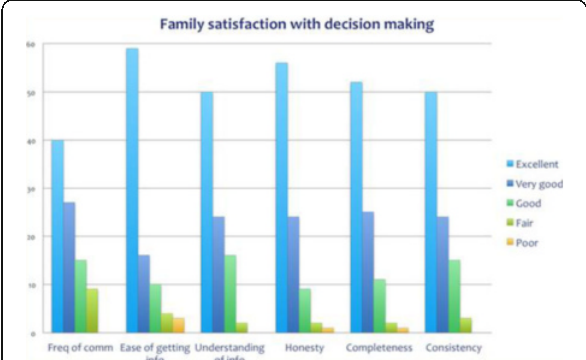
Fig. 92 (abstract A214). Family satisfaction with decision making